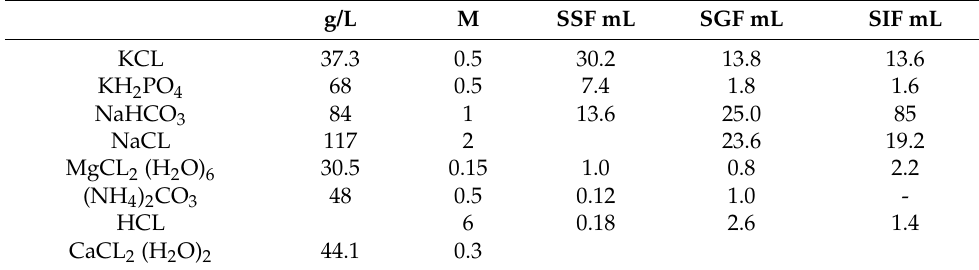
Table 1. Chemical compositions of simulated solutions for in vitro